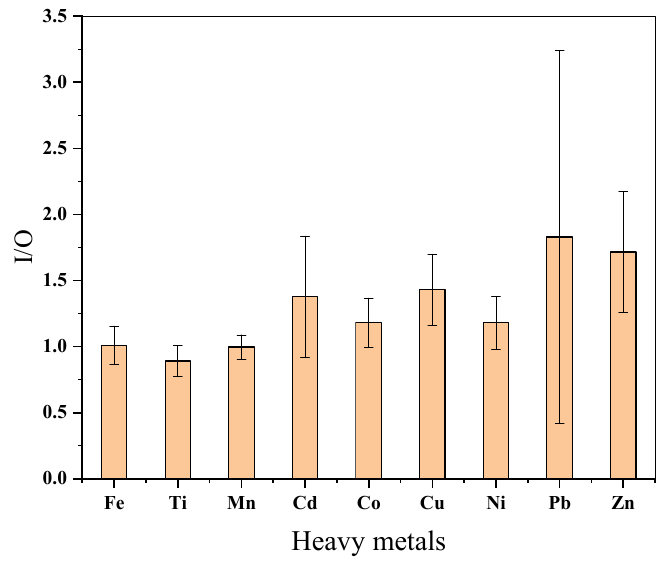
Figure 3. The indoor and outdoor ratio (I/O) in elementary school environment.